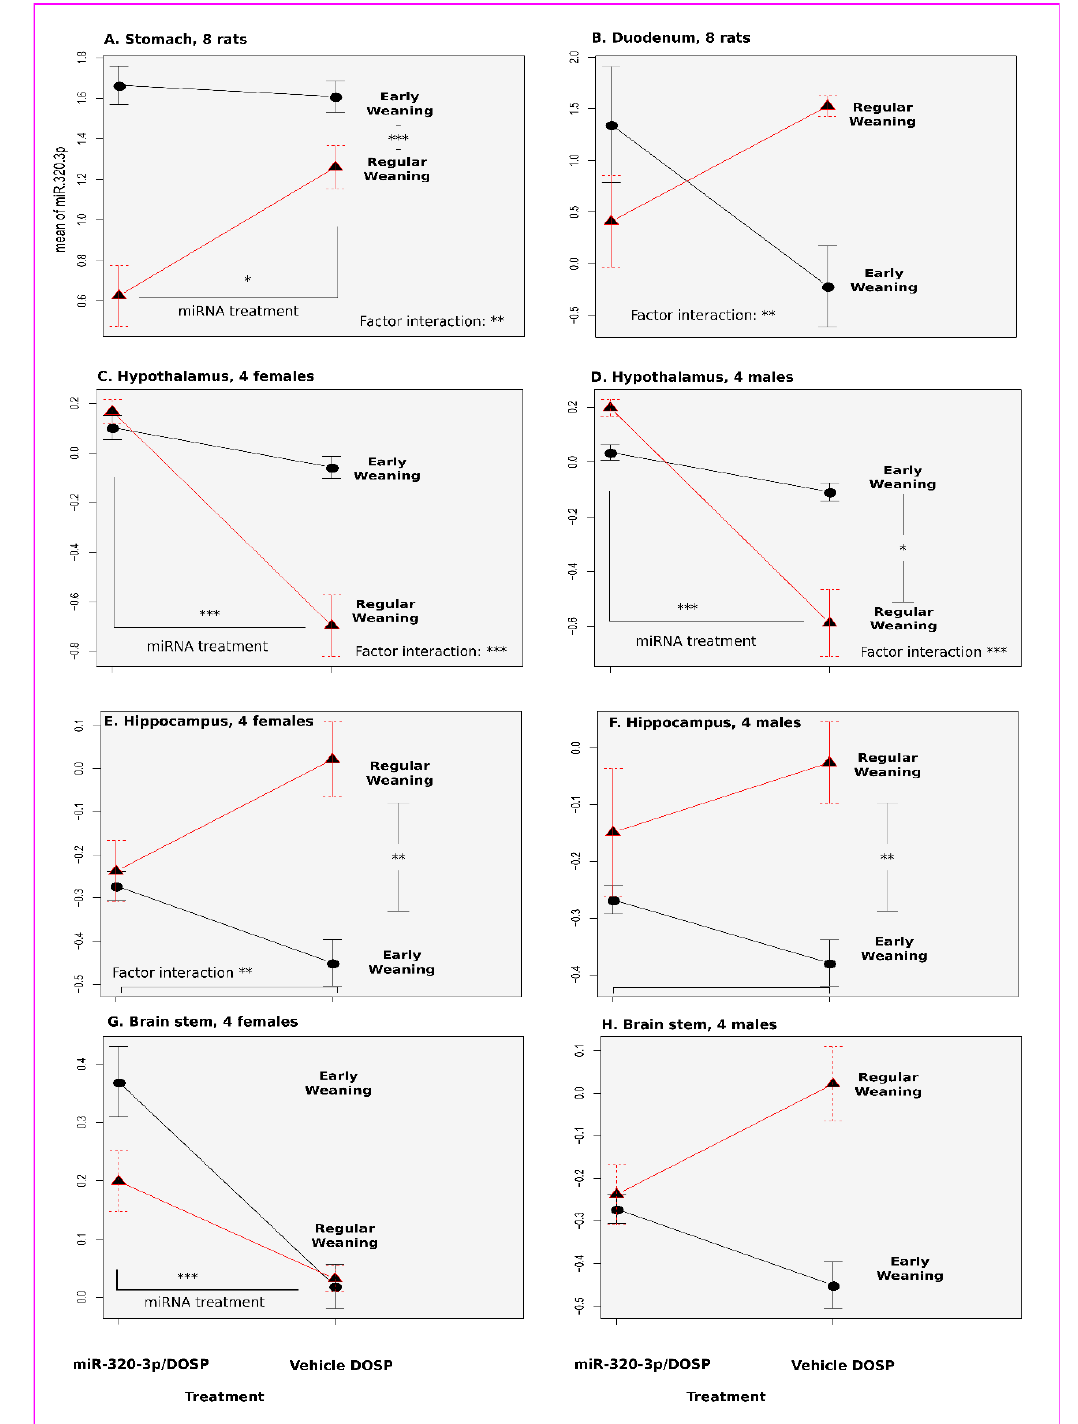
Figure 2. Long-term effects of miR-320-3p/DOSP treatment on miR-320-3p expression. The plot of means shows the expression of miR-320-3p in tissue extracts of the stomach ( A ), duodenum ( B ), hypothalamus ( C , D ), hippocampus ( E , F ), and brain stem ( G , H ). The miR-320-3p levels in brain stem extracts of female and male rats were strikingly different. A strong effect was found in the stomach but not in the duodenum. The light gray background indicates that rats were sacrificed in the dark phase. Note that the lines joining the points underline the direction of the variations, they are not curves of variations. * p < 0.05; ** p < 0.01; *** p < 0.001.